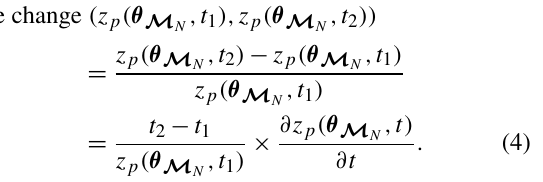
Figure 3. Distribution of selected models. Frequency of selected model (in %) with respect to all time series, i.e. for all massifs and altitudes. For the selection procedure and the definition of signifi- cance, we refer to Sect.